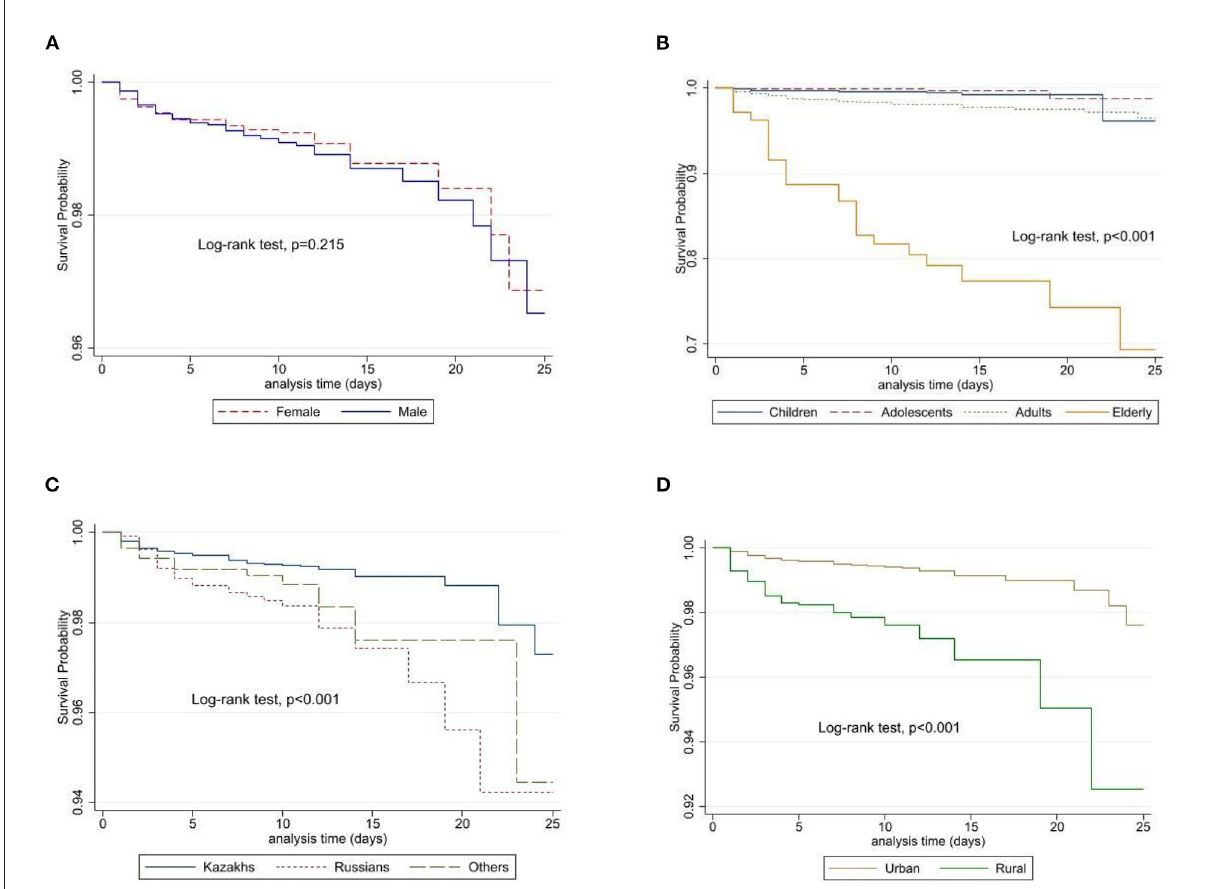
FIGURE5 Unadjusted survival probabilities by gender (A) , age category (B) , ethnicity (C) , and place of residence (D) among patients in Kazakhstan.